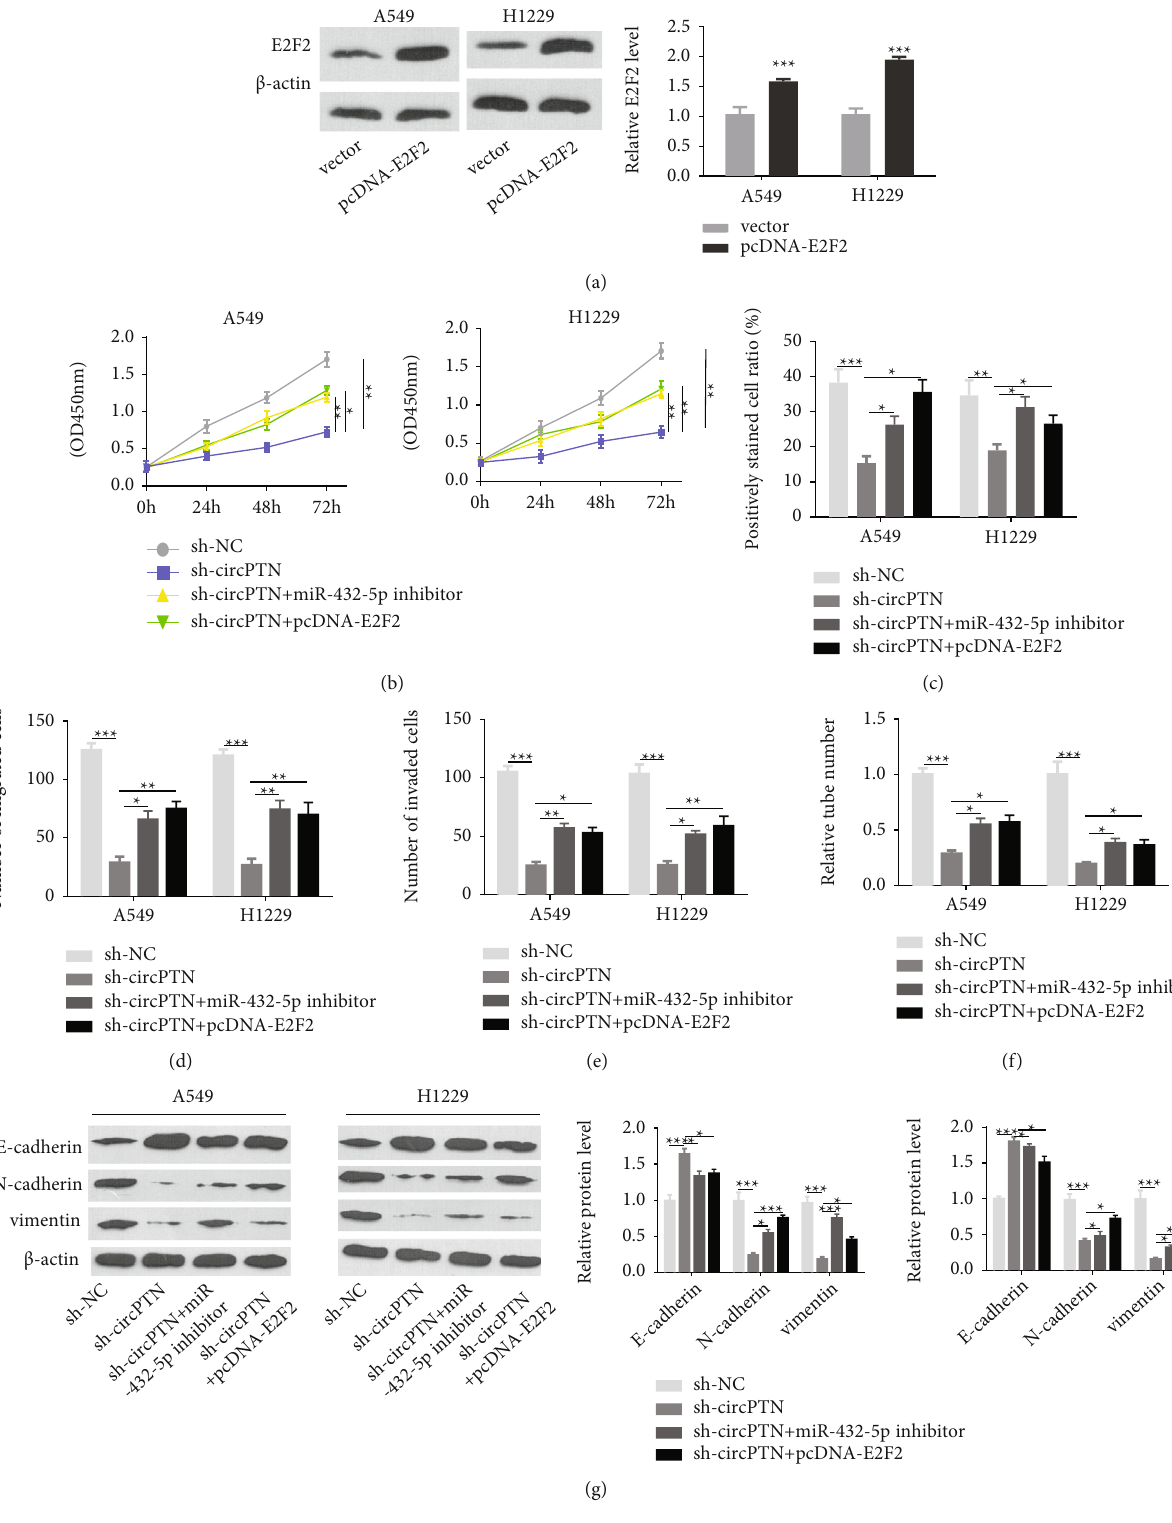
Figure 5: circPTN regulates the malignant phenotype of NSCLC cells through the miR-432-5p/E2F2 axis. (a) The protein levels of E2F2 in A549 and H1229 cells upon the transfection of pcDNA-E2F2 expression plasmid. (b) CCK-8 proliferation assay in A549 and H1229 cells with indicated treatment. (c) EdU incorporation assay in A549 and H1229 cells with indicated treatment. (d) Transwell-migration assay in A549 and H1229 cells with indicated treatment. (e) The transwell-invasion experiment in A549 and H1229 cells with indicated treatment. (f) The tube formation assay in A549 and H1229 cells with indicated treatment. (g) WB was performed to detect EMT-related proteins (E-cadherin, N-cadherin, and vimentin) in A549 and H1229 cells with indicated treatment. * P < 0 : 05 ; ** P < 0 : 01 ; and *** P < 0 : 001